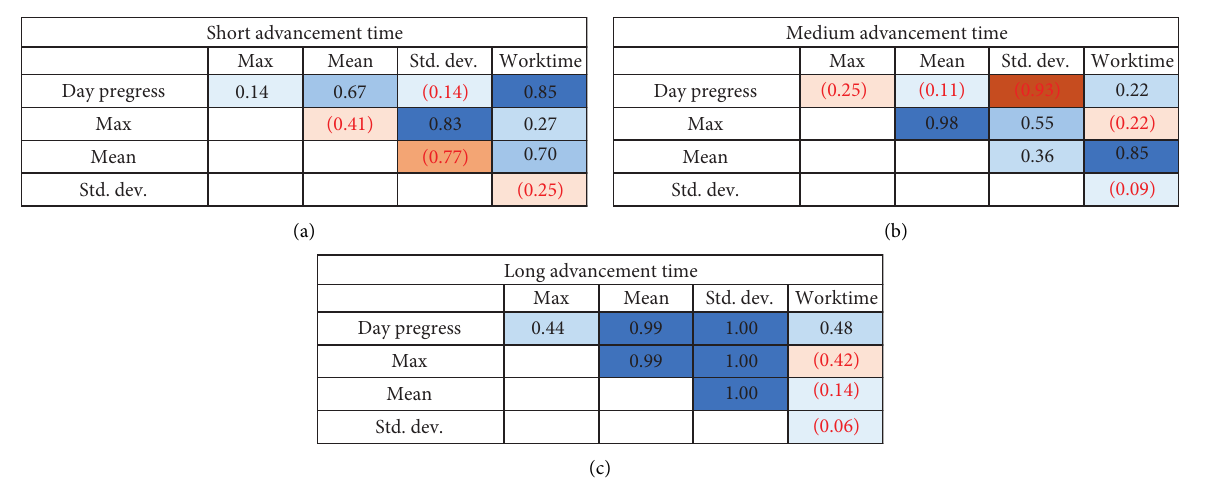
Figure 10: Linear correlation evaluation